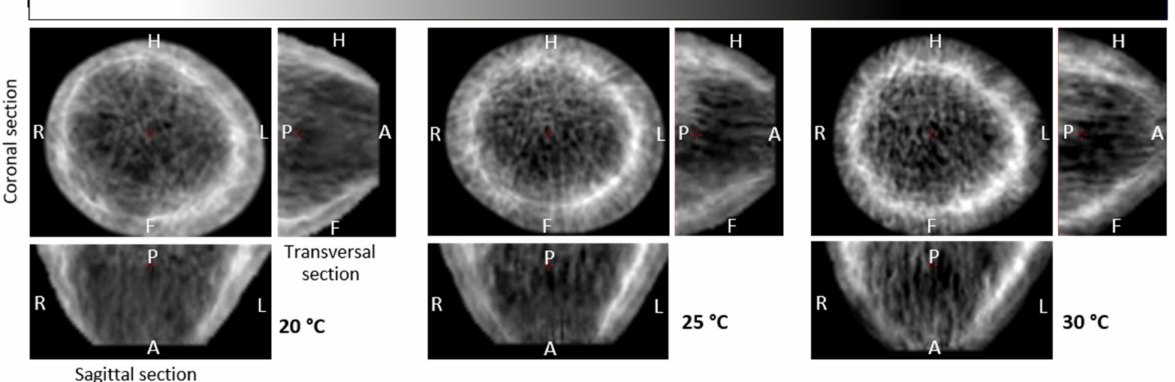
Figure 17. Reconstructed MPR images of breast cross-sections of Patient 1 studied in vivo at a water temperature of 20 ◦ C, 25 ◦ C, and 30 ◦ C presented in standard and inverted grayscale, respectively, and before and after automatic removal of water pixels around the breast (H—head, F—feet, L—left, R—right, P—posterior,